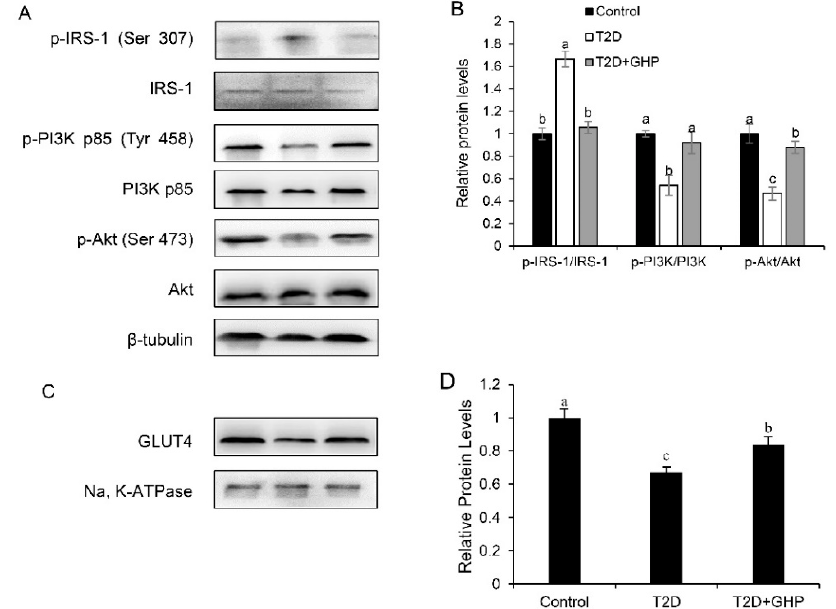
Figure 5. GHP supplementation activates the IRS-1/PI3K/Akt pathway and stimulates glucose transport in T2D mice. ( A ) Skeletal muscle protein contents of IRS-1, p-IRS-1, PI3K, p-PI3K, Akt and p-Akt and ( B ) quantification data. ( C ) Skeletal muscle plasma membrane protein contents of GLUT4 and ( D ) quantification data. Protein contents of IRS-1, p-IRS-1, PI3K, p-PI3K, Akt and p-Akt were adjusted to β -tubulin as the loading control, and content of GLUT4 was adjusted to Na, K-ATPase as the loading control. Results were expressed as means ± SEM, n = 8. Different letters (a–c) indicate significantly difference ( p < 0.05).